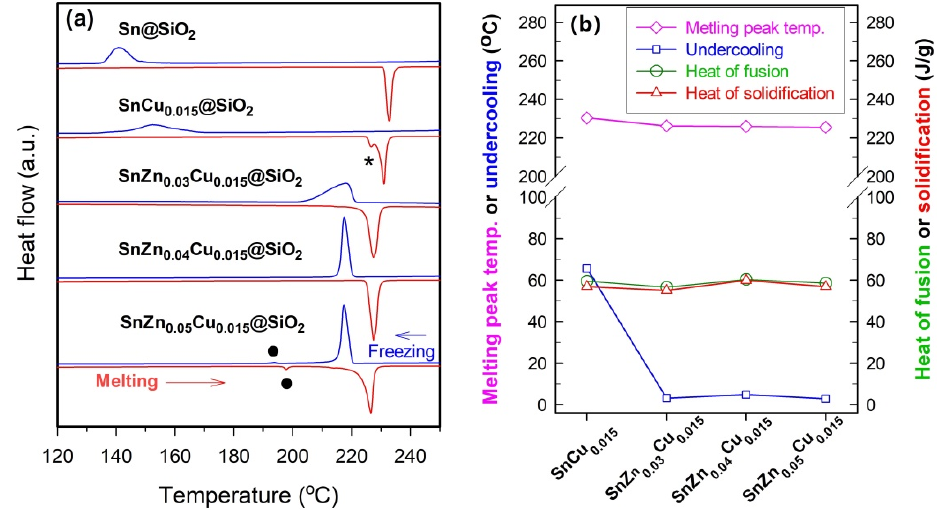
Figure 6. DSC curves ( a ) and phase change properties ( b ) of SiO 2 -encapsulated SnZnCu (encapsulation times = 1) of different amounts of Zn. The results obtained from Sn@SiO 2 and SnCu 0.015 @SiO 22 microspheres are also shown for comparison.